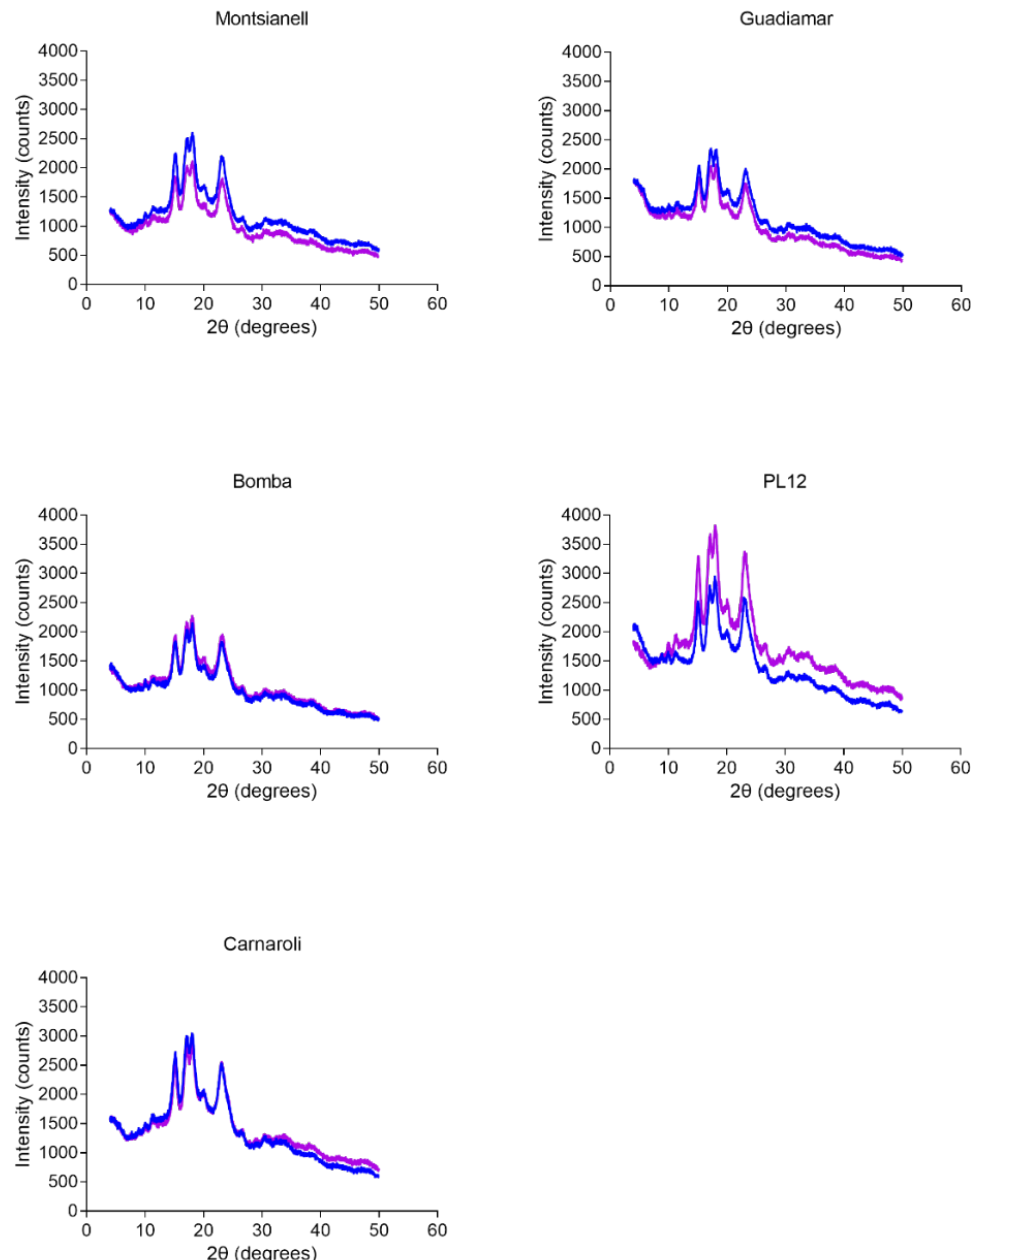
Figure 2. Diffractograms for all the cultivars and grain types studied. The pearled cultivars are on the left and the crystalline cultivars are on the right. Whole grain diffractograms are represented with a purple line and chalky grain diffractograms are represented in blue.